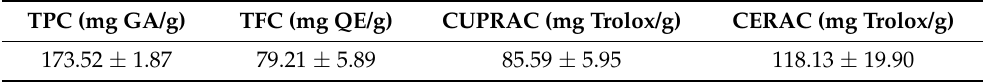
Table 1. Antioxidant properties of pollen